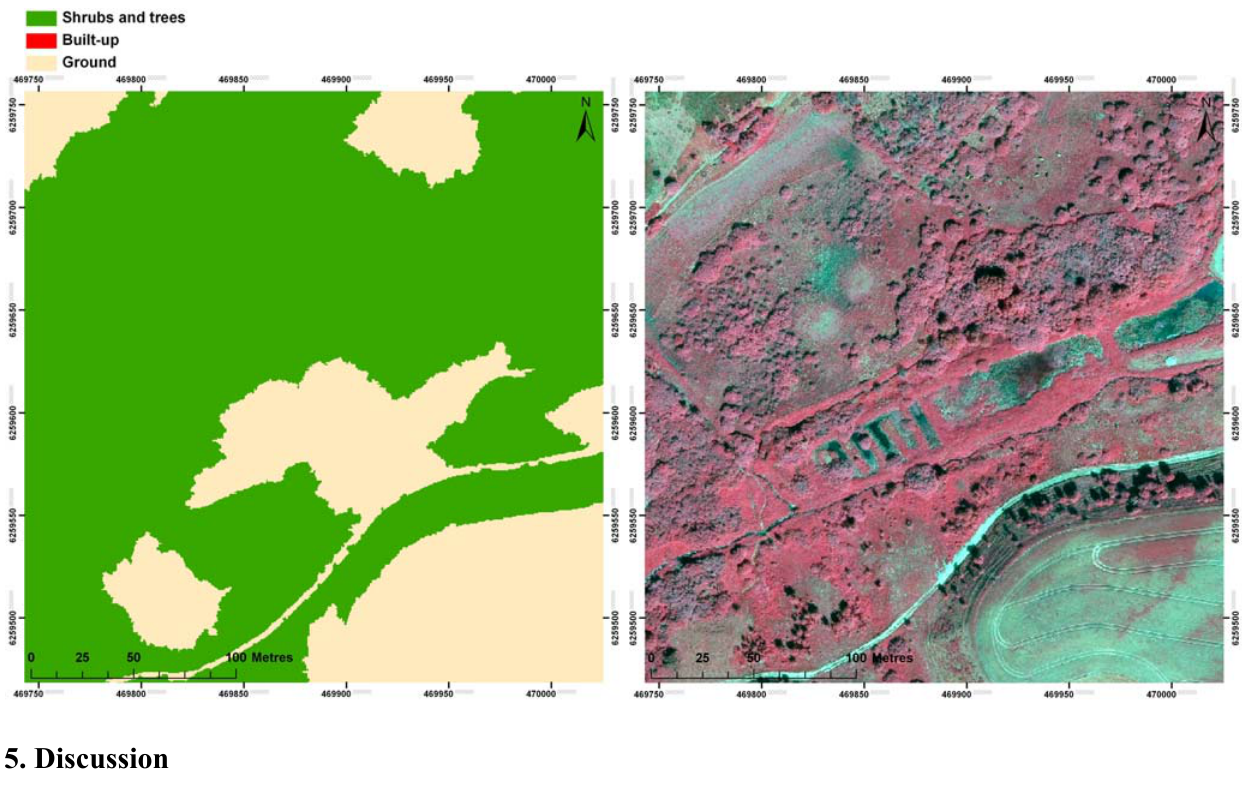
Figure 16. This example (2) shows the result of the classification based on the CIR images and the four features derived from the CART analysis. As in Figure 14, many ground objects have been misclassified as shrubs and